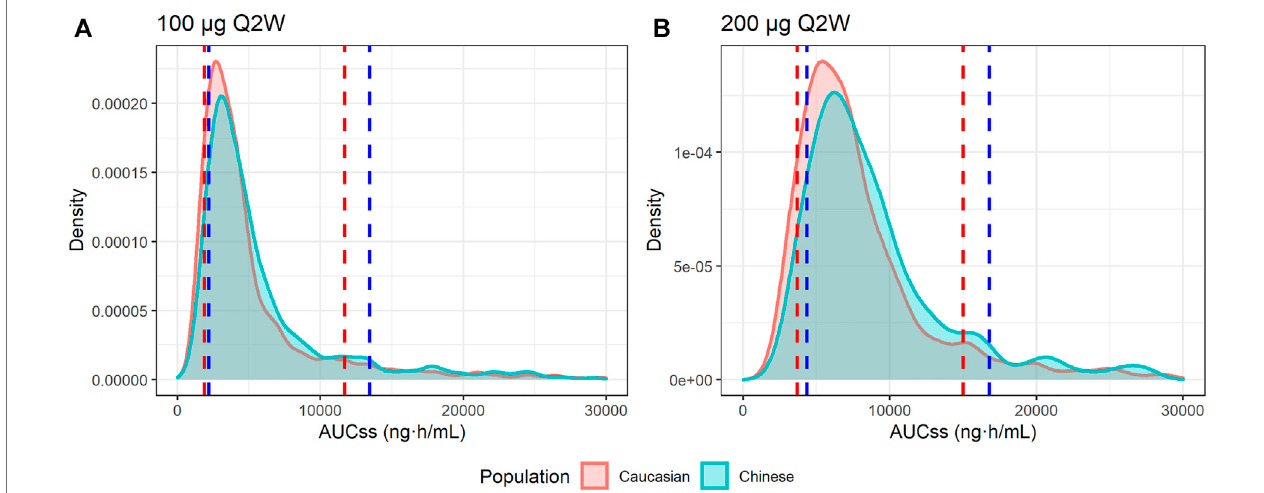
FIGURE6| DistributionsofthesimulatedAUCatsteadystate(AUC ss ). (A) AUC ss of100 μ gevery2 weeks(Q2W); (B) AUC ss of200 μ gQ2W.Theredareaandred dashed lines represent the distribution and 10th and 90th quantiles of the AUC ss of Caucasian virtual subjects, respectively. The blue area and blue dashed lines represent the distribution and 10th and 90th quantiles of AUC ss of Chinese virtual subjects,